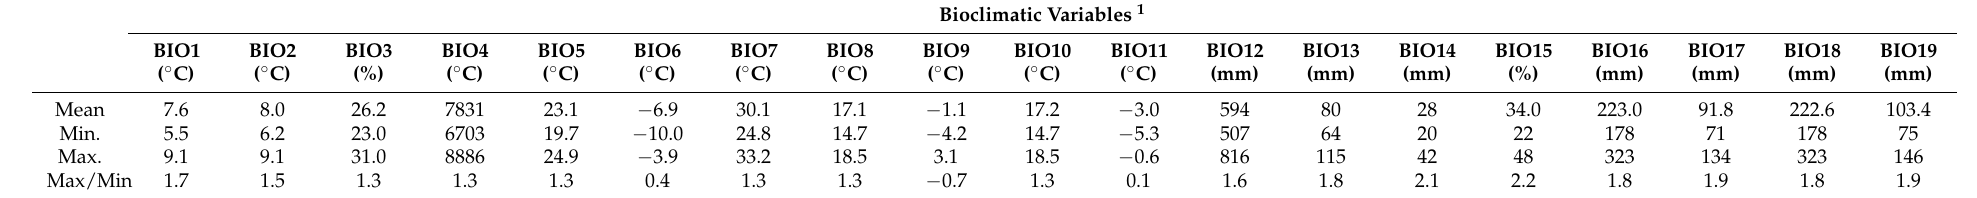
Table 1. Bioclimatic variables on research plots ( n = 195; source of data: global climate and weather data,